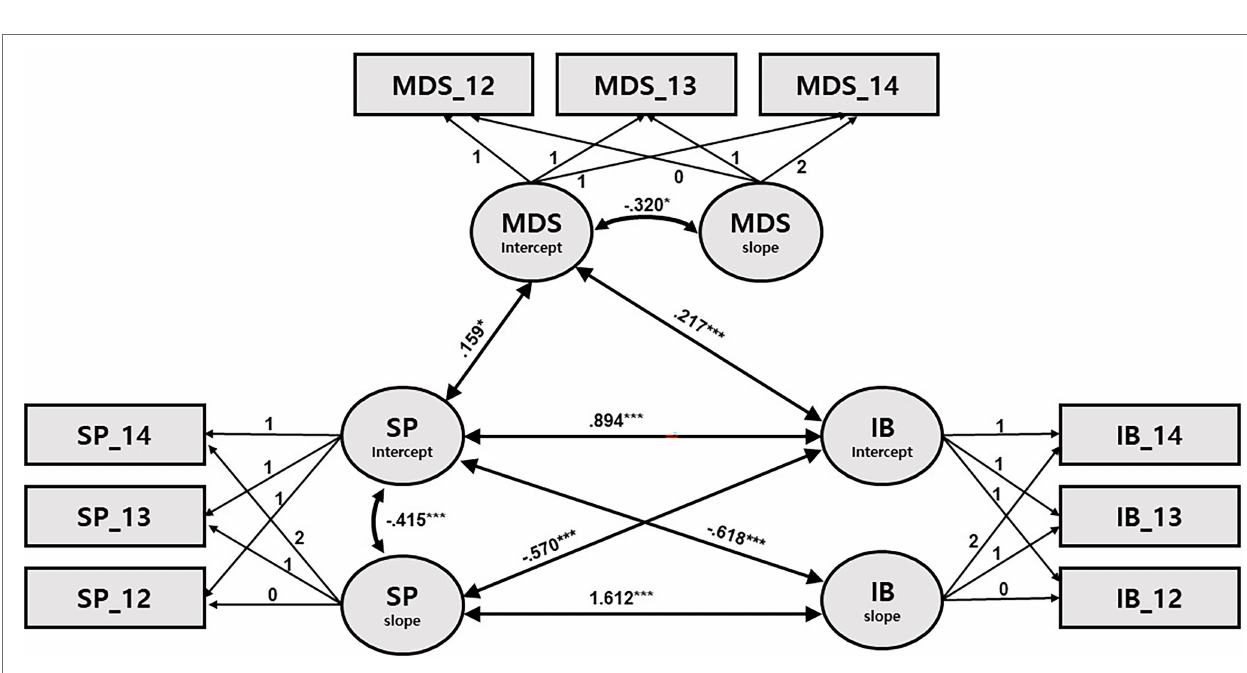
FIGURE 4 | Path diagram for latent growth modeling of sleep problems, internalizing behaviors, and maternal depressive symptoms. SP: sleep problems; IB: internalizing behaviors; and MDS: maternal depressive symptoms. Only significant path coefficients are shown. * p < 0.05, ** p < 0.001, and *** p < 0.001.